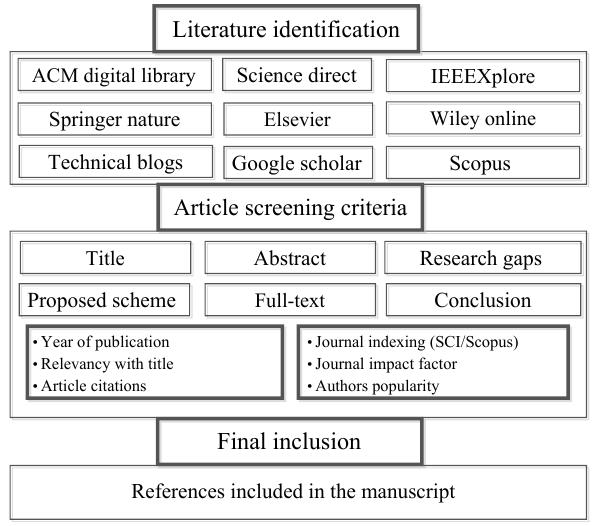
Figure 1. Prisma diagram of the proposed